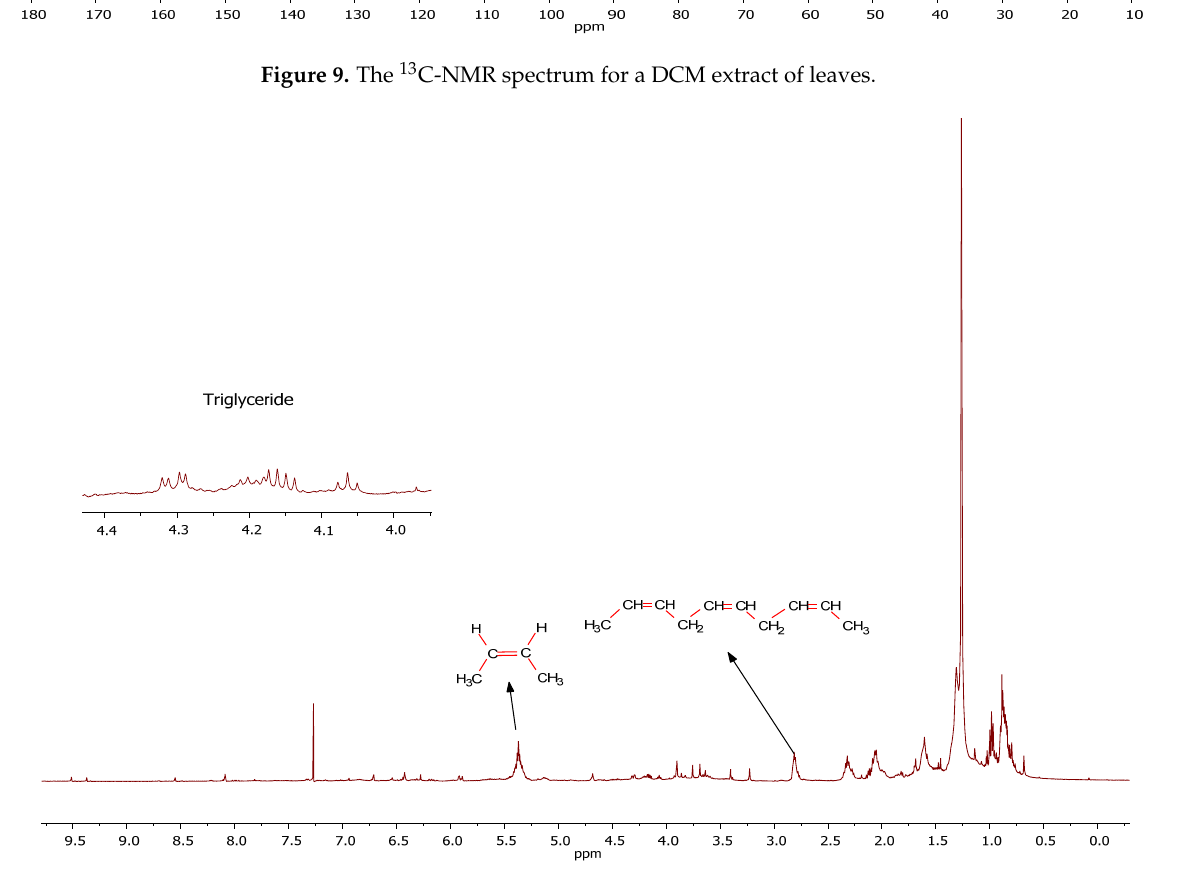
Figure 10. The 1 H-NMR spectrum for a DCM extract of leaves.